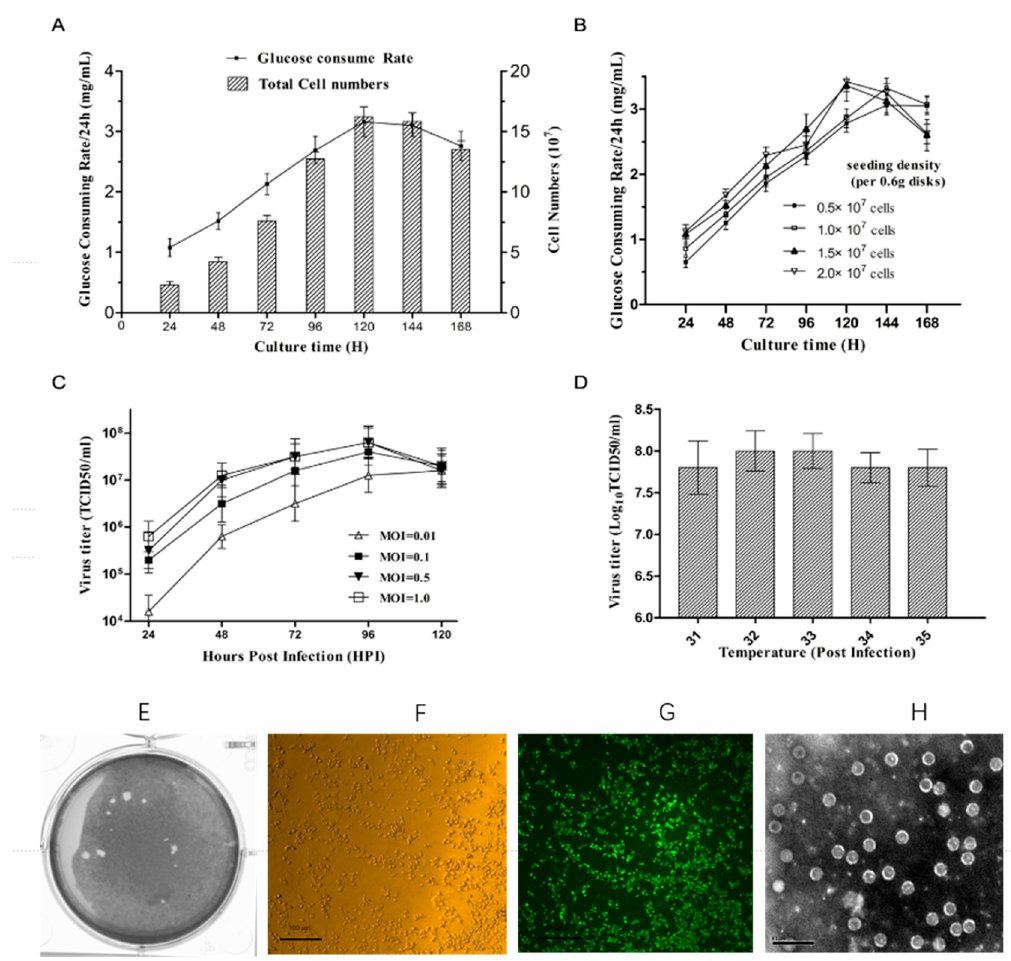
Figure 1. Vero cell culture in a micro bioreactor and optimization of the virus yield. ( A ) The total cell count in a container (volume = 30 mL;) and the GCR (black square; grams of glucose consumed every 24 h per liter) in the culture container of the micro bioreactor. ( B ) GCR in the bioreactor using inocula at different cell densities (0.5 × 10 7 cells (black squares), 1.0 × 10 7 cells (white squares), 1.5 × 10 7 cells (black triangles), and 2.0 × 10 7 cells (white triangles). ( C ) Viral production (yield) at different MOIs. MOI = 0.01 (white triangle), 0.1 (black square), 0.5 (black triangle), and 1.0 (white square). ( D ) Viral production under different temperatures (31, 32, 33, 34, and 35 °C) in the mini bioreactor. ( E ) Plaque purification of clonal CVA16. ( F ) CPE of CVA16-infected Vero cells at 68 hpi; magnification: 200. ( G ) Immunofluorescence staining of CVA16-infected Vero cells at 68 hpi; magnification: 200. ( H ) Transmission electron microscopy of CVA16. Scale bar represents 50 nm. GCR, glucose consumption rate; MOI, multiplicity of infection; CVA16, Coxsackie virus A16; CPE, cytopathic effect; hpi, hours post-infection.